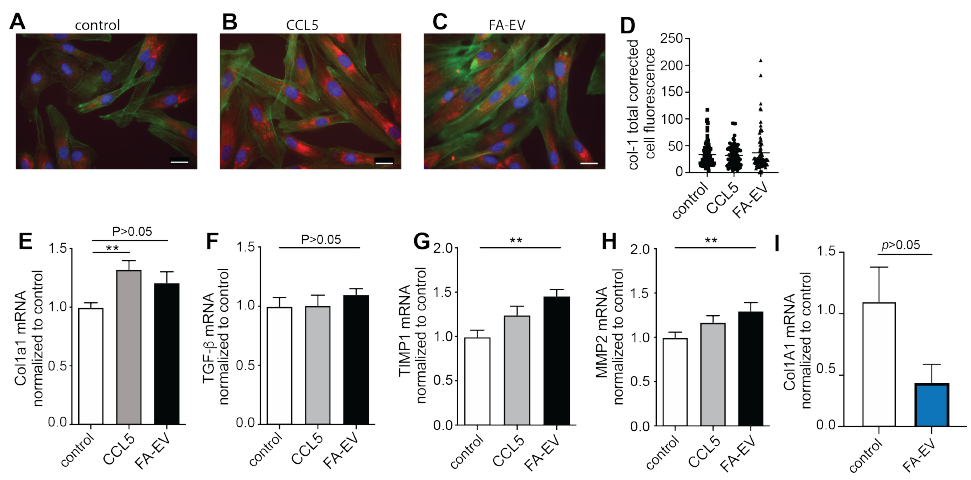
Figure 5. Expression of fibrotic markers in FA-EV–treated TWNT4 cells and primary HSC. Repre- sentative phalloidin staining and collagen staining after treatment of TWNT4 cells with vehicle ( A ), CCL5 ( B ) or FA-EV ( C ); scale bar: 20 µ m. ( D ) Quantitation of red (collagen) fluorescence. mRNA expression levels of COL1A1 ( E ), TGF - β ( F ), TIMP1 ( G ) and MMP2 ( H ), after treatment with